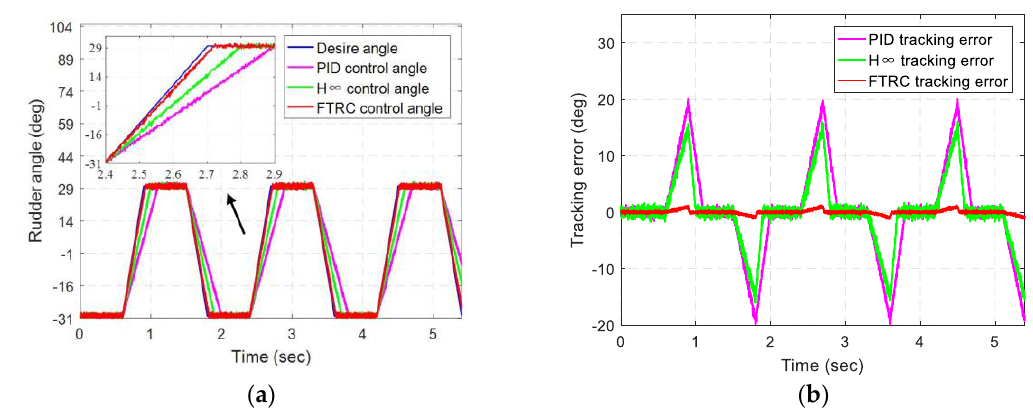
Figure 11. Actual response and error of different algorithm under input step signal: ( a ) system response; ( b ) system response error.